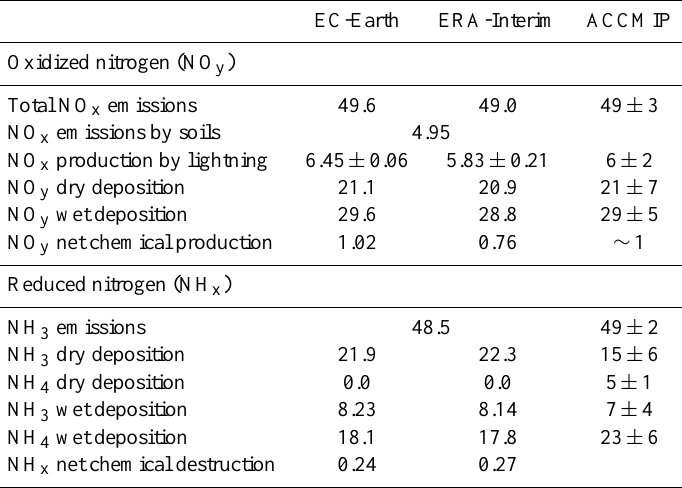
Table A3. Global budgets of oxidized and reduced reactive nitrogen (TgNyear − 1 ) for the reference EC-Earth simulation and the correspond- ing ERA-Interim simulation, compared with the ACCMIP multi-model means and standard deviations for the year 2000 from Lamarque et al. (2013b). The standard deviations indicated for the NO x production by lightning in our simulations are calculated from the interannual variability.